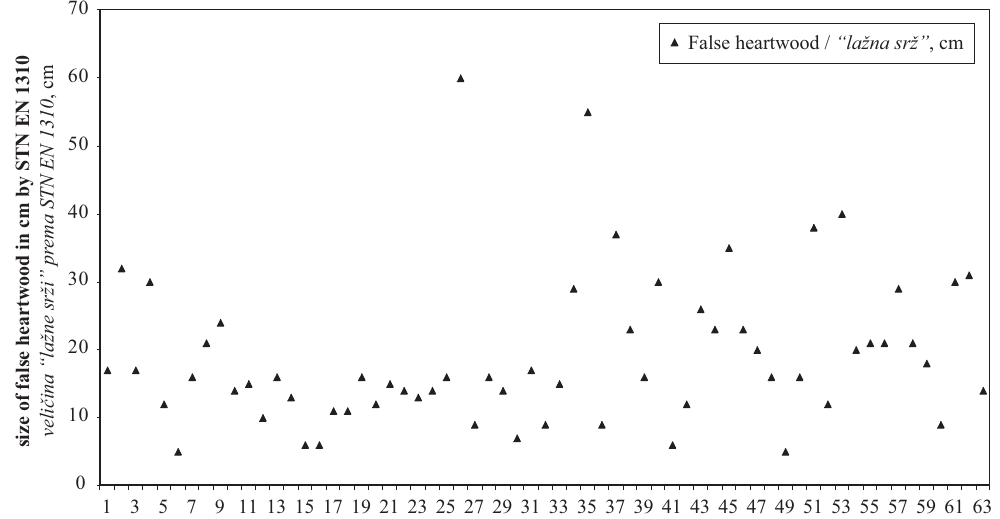
Figure 3 Size of false heartwood in cm according to STN EN 1310 Slika 3 . Veličina “lažne srži” u centimetrima prema STN EN